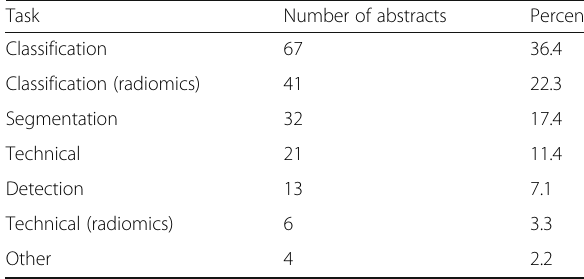
Table 5 Use cases of machine learning